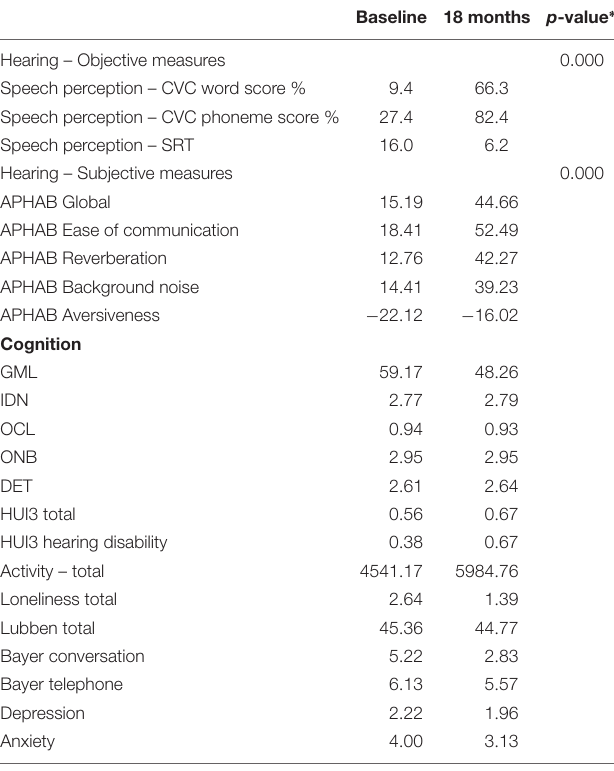
TABLE 4 | Mean outcomes at baseline and 18 months ( N = 20). TABLE 5 | Regressions for baseline – 18 months